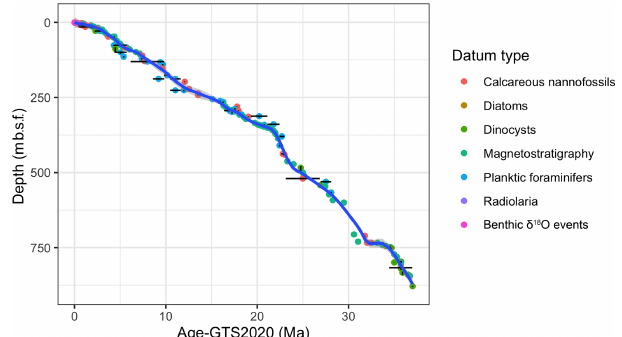
Figure 2. Age model of Site 1168. Points indicate the data (Stickley et al., 2004). Colours indicate data types. The blue curve indicates the loess smooth curve with a span of 0.1 throughout the studied interval, which we resampled to obtain ages for the samples used in this